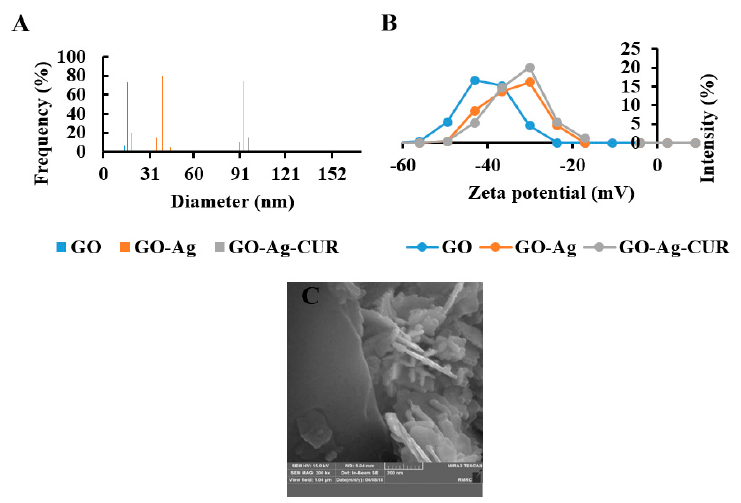
Figure 3. ( A ) DLS spectra of GO, GO-Ag, and GO-Ag-CUR ( B ) Zeta potential of GO, GO-Ag, and GO-Ag-CUR ( C ) FESEM image of